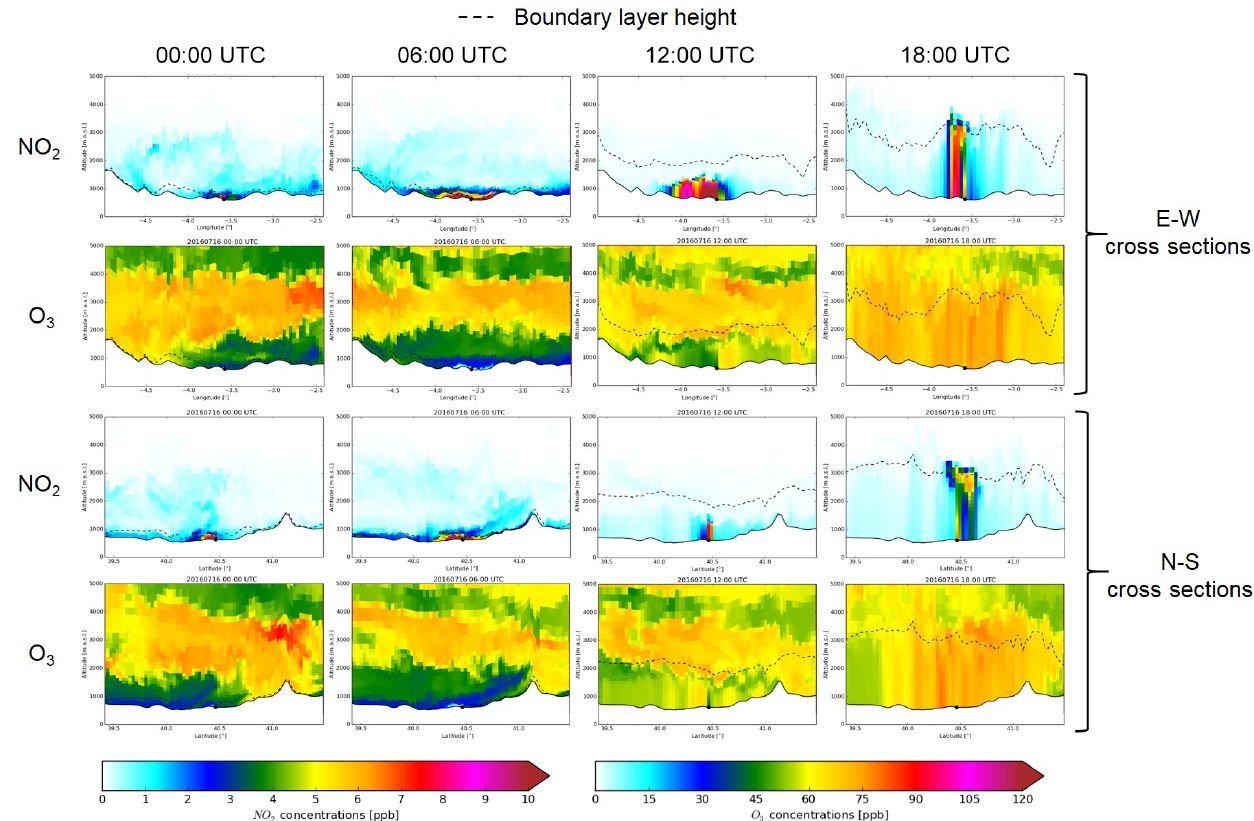
Figure 6. Simulated longitudinal and latitudinal vertical cross sections of NO 2 and O 3 for 16 July 2016 (WRF_70 run). See Fig. 1 to consult the latitudinal and longitudinal